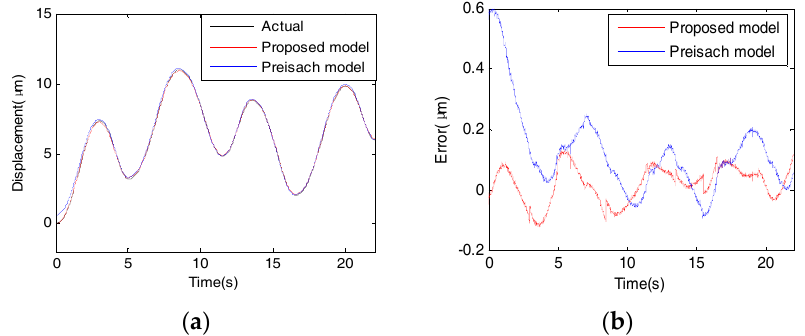
Figure 19. The responses to the random triangular excitation with high rate. ( a ) The output displacement curves; ( b ) error curves. Table 7. The modeling errors with sinusoidal excitations.